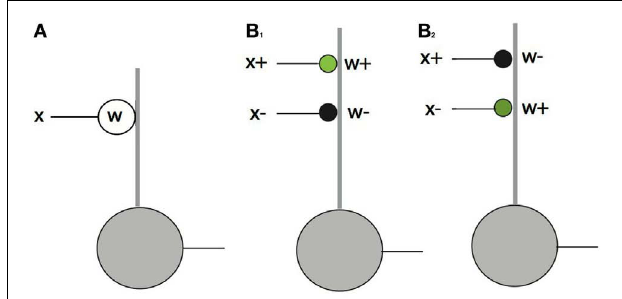
FIGURE 4 |The feed forward pathway connections. The dot product computation illustrates the difference between conventional neural models and signed labeled lines. In the diagram thick lines denote dendrites and thin lines denote axons. Green circles = excitatory synapses. Black circles = inhibitory synapses. (A) If synapses and inputs could change sign then they could be handled simply with a single contact. (B) In the actual case there are four possibilities, each of which needs a separate synapse. Only one of x + w + and x + w − can be non-zero at any one time and the same holds for x − w + and x − w − . Complementary pairs are required be non-zero to faithfully represent a dot product as shown for the cases of B 1 : x + w + > 0 and B 2 : x − w + >